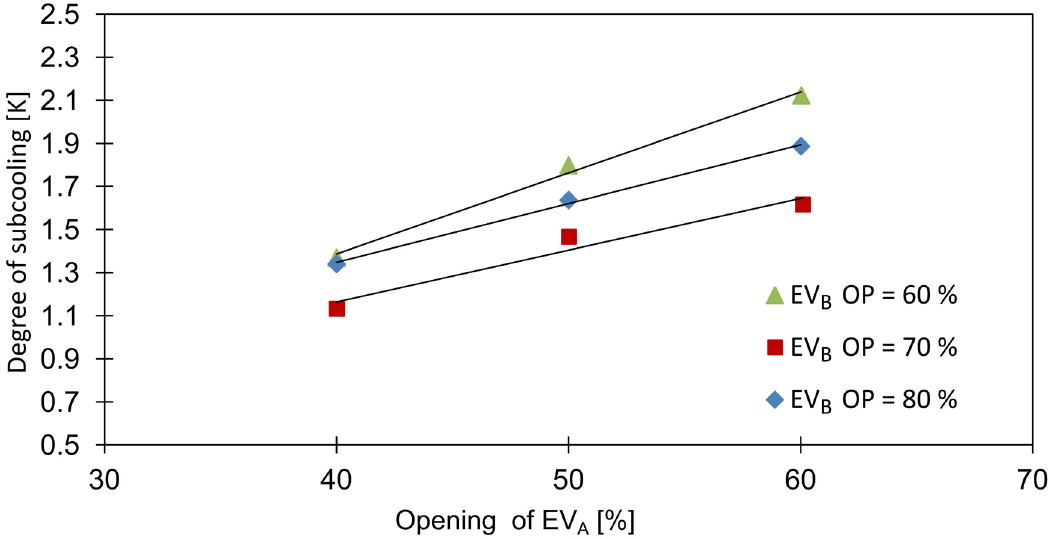
Figure 9. Influence of expansion valves openings on subcooling